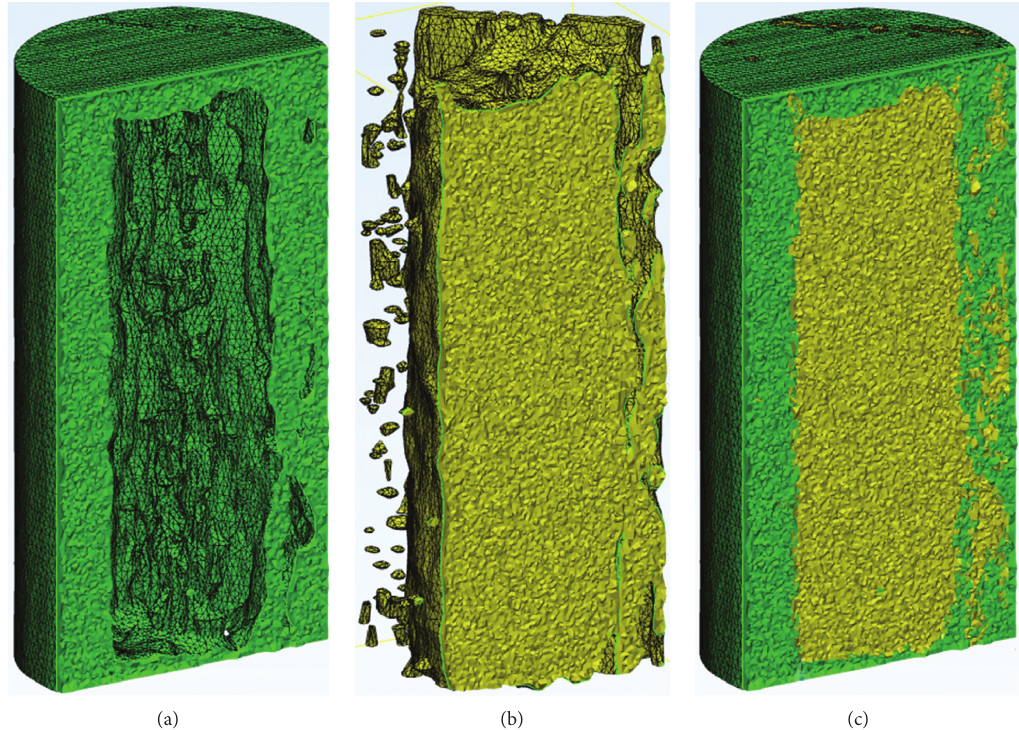
Figure 10: Profile of finite element mesh model of acid-corroded sandstone. (a) Corrosion zone. (b) Uncorroded zone. (c) Rock sample as a whole.